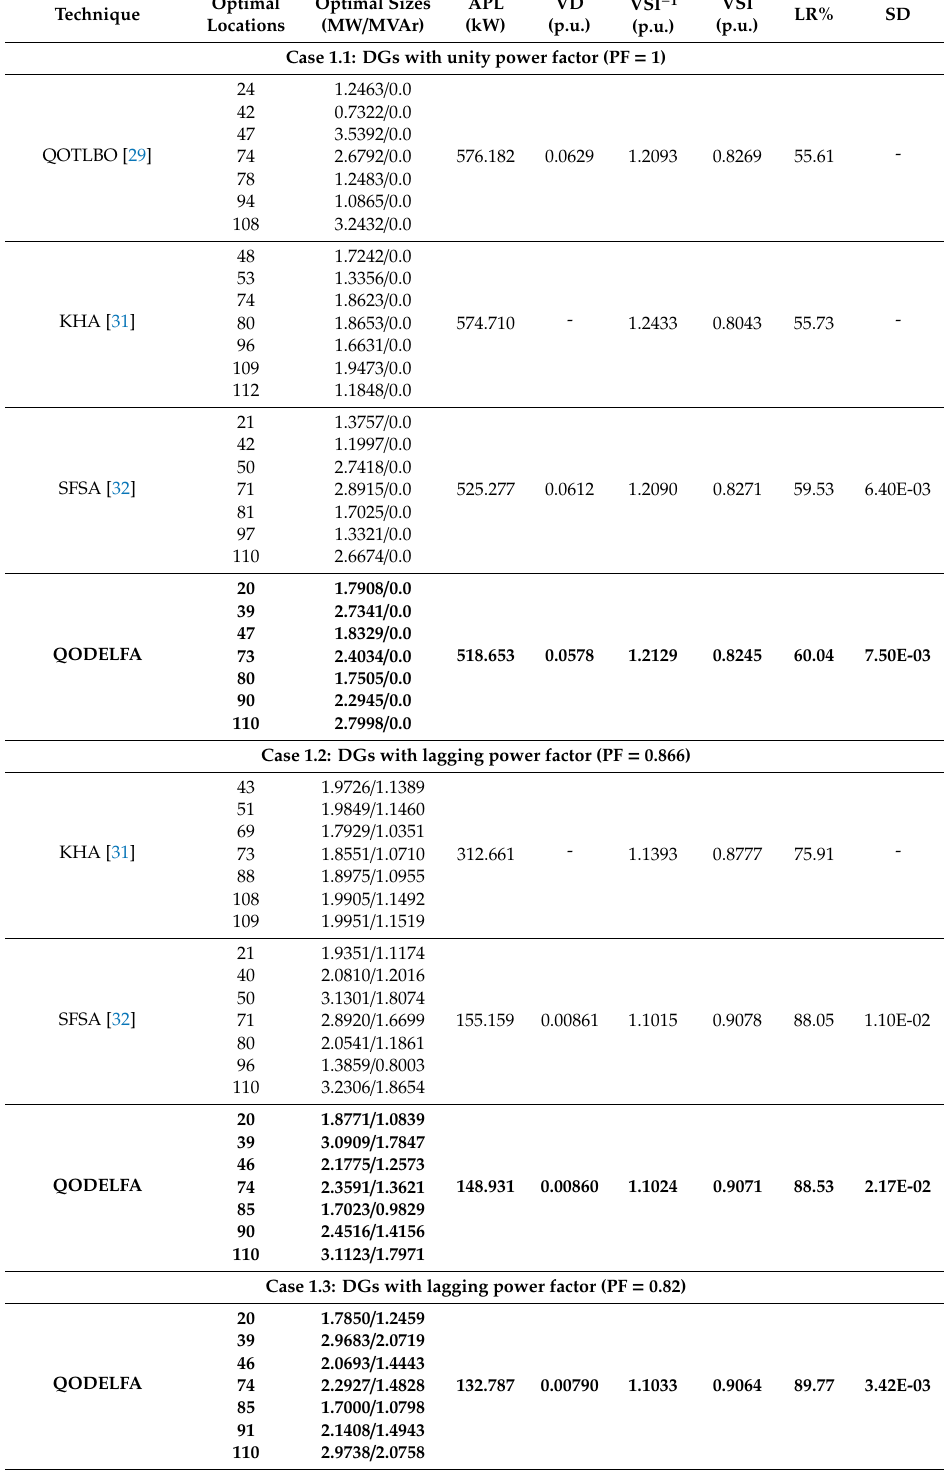
Table 9. Results for the IEEE 118-bus RDS with OF 1